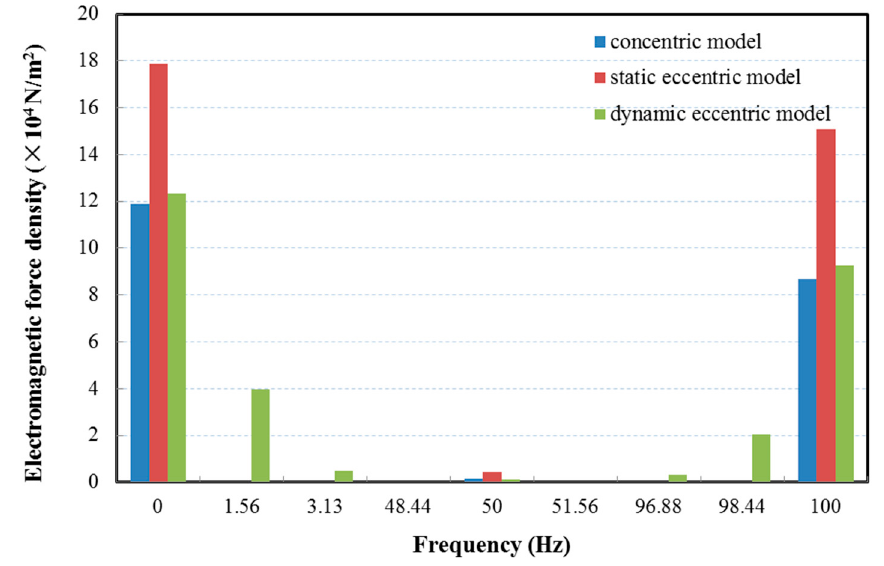
Figure 14. Fast fourier transformation (FFT) of electromagnetic force density with different eccentric models.